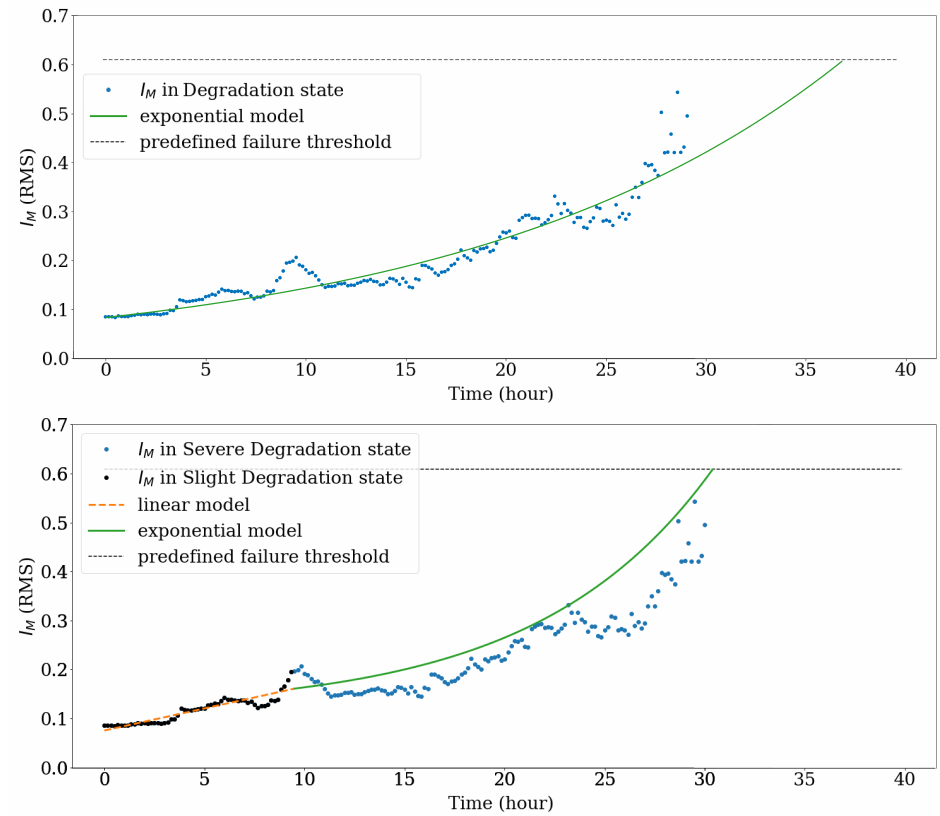
Figure 6. I M degradation trajectories and regression models for single-stage degradation process ( top ) and 2-stage degradation process ( bottom